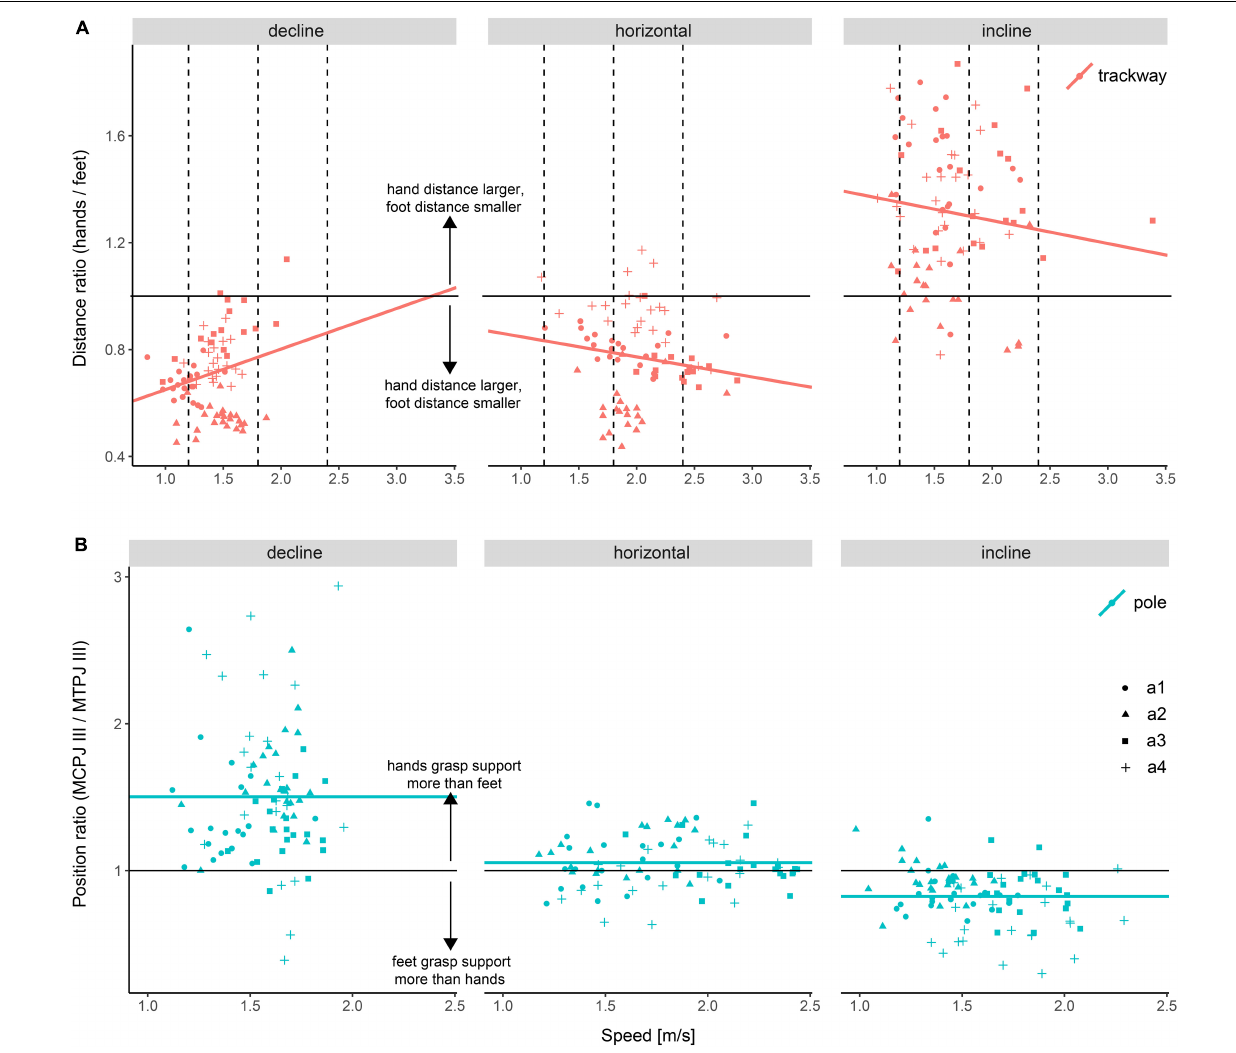
FIGURE 5 | Differences in autopodial placement depending on support orientation. (A) Ratio of the distance between hands to the distance between feet on the flat trackway. (B) Ratio between the position of the metacarpophalangeal joint III (MCPJ III) and metatarsophalangeal joint III (MTPJ III) on the pole. Position was measured as the distance from the lower margin of the pole. Dashed lines indicate the speed values at which setups were compared statistically post hoc (not relevant for (B) as speed had no significant effect and hence was removed from the final regression model). a1–a4 refer to the studied